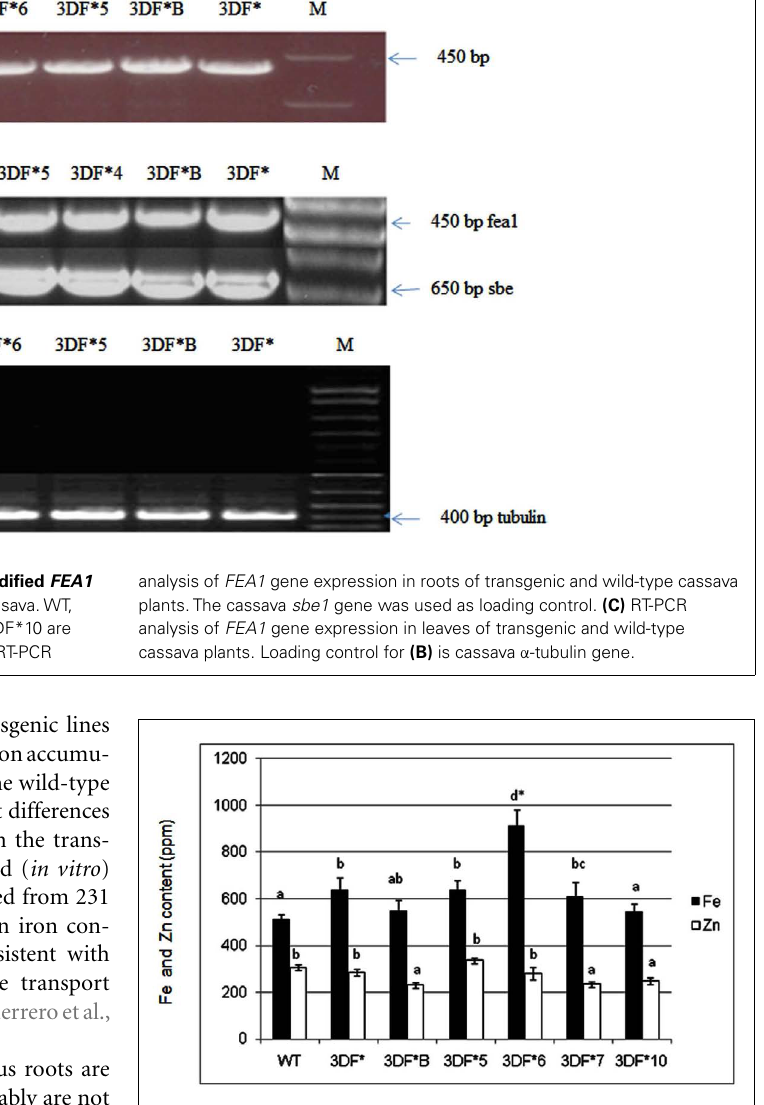
FIGURE 2 | Iron and zinc content of 6-week-old in vitro fibrous roots of FEA1 transgenic and wild-type cassava plants. The results represent the mean of three replicates ( ± standard deviation).White bars represent zinc and black bars represent iron.WT, wild type; 3DF*, 3DF*B, 3DF*4, 3DF*5, 3DF*6, 3DF*7, and 3DF*10 are FEA1 transgenic cassava plants. *Numbers with same letters show no statistical difference, different letters mean statistical difference at 95% confidence